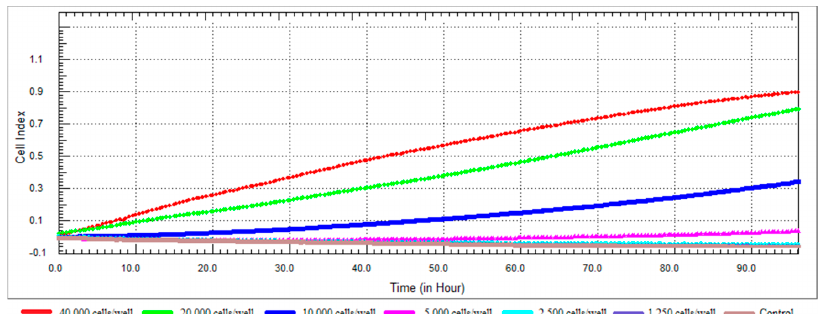
Figure 2. Dynamic monitoring of cell adhesion and proliferation using the xCELLigence system. RL95-2 cell at a density of 40,000; 20,000; 10,000; 5000; 2500; 1250 cells/well in E-Plates 96 were observed during 96 h.